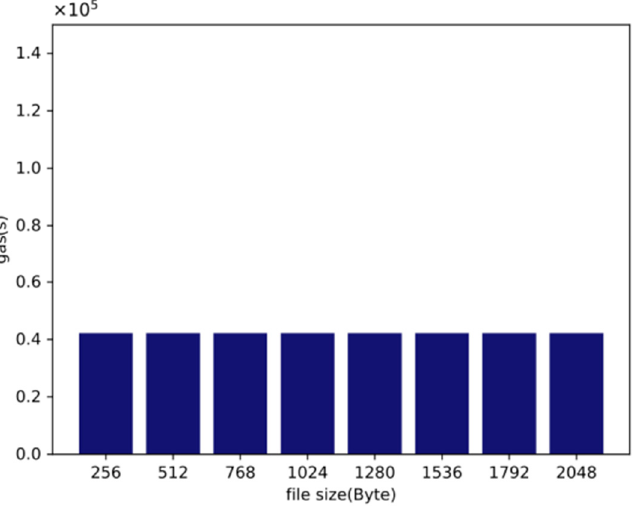
Figure 4. Storage overhead required for blockchain verification based on different file sizes.